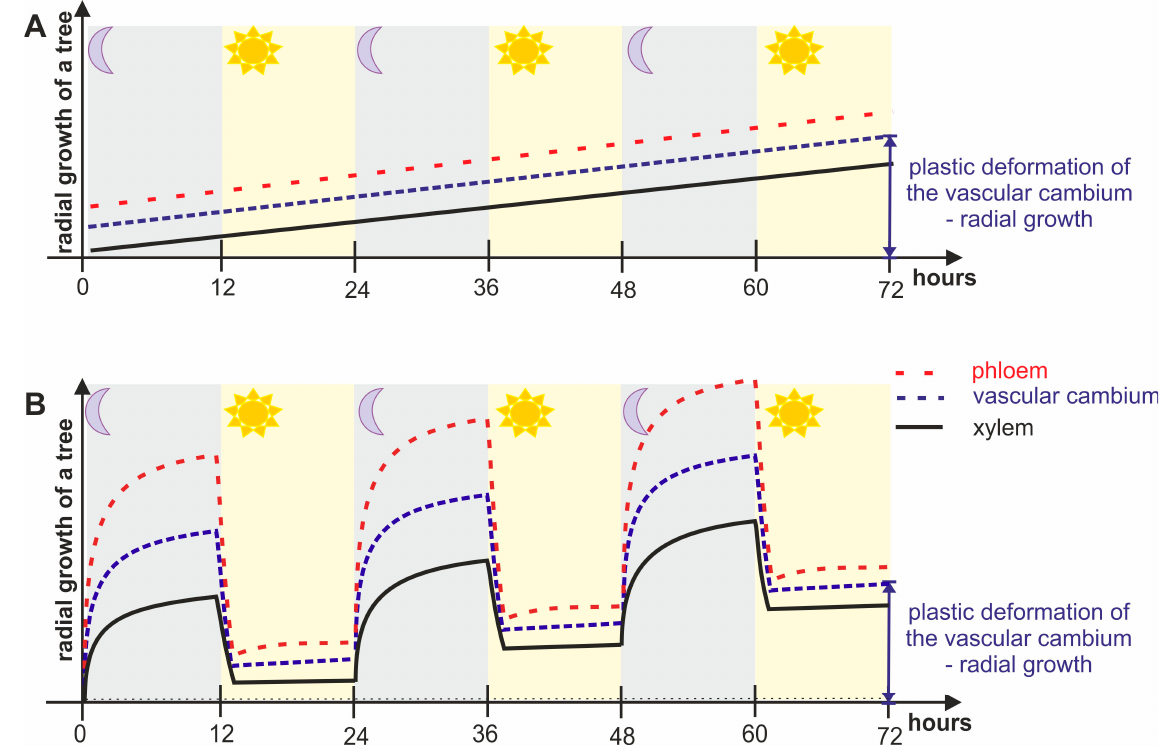
Figure 9. Comparison of two models of radial growth of the vascular cambium. ( A ) A synthesis of previous views of radial growth in trees, in which radial growth is independent of the dial cycle. ( B ) Radial growth of the vascular cambium according to the osmo-mechanical hypothesis, which strongly links radial growth to the water status of phloem. In both cases, the predicted outcome of radial growth is the same, but the mechanisms by which it is achieved are di ff erent.